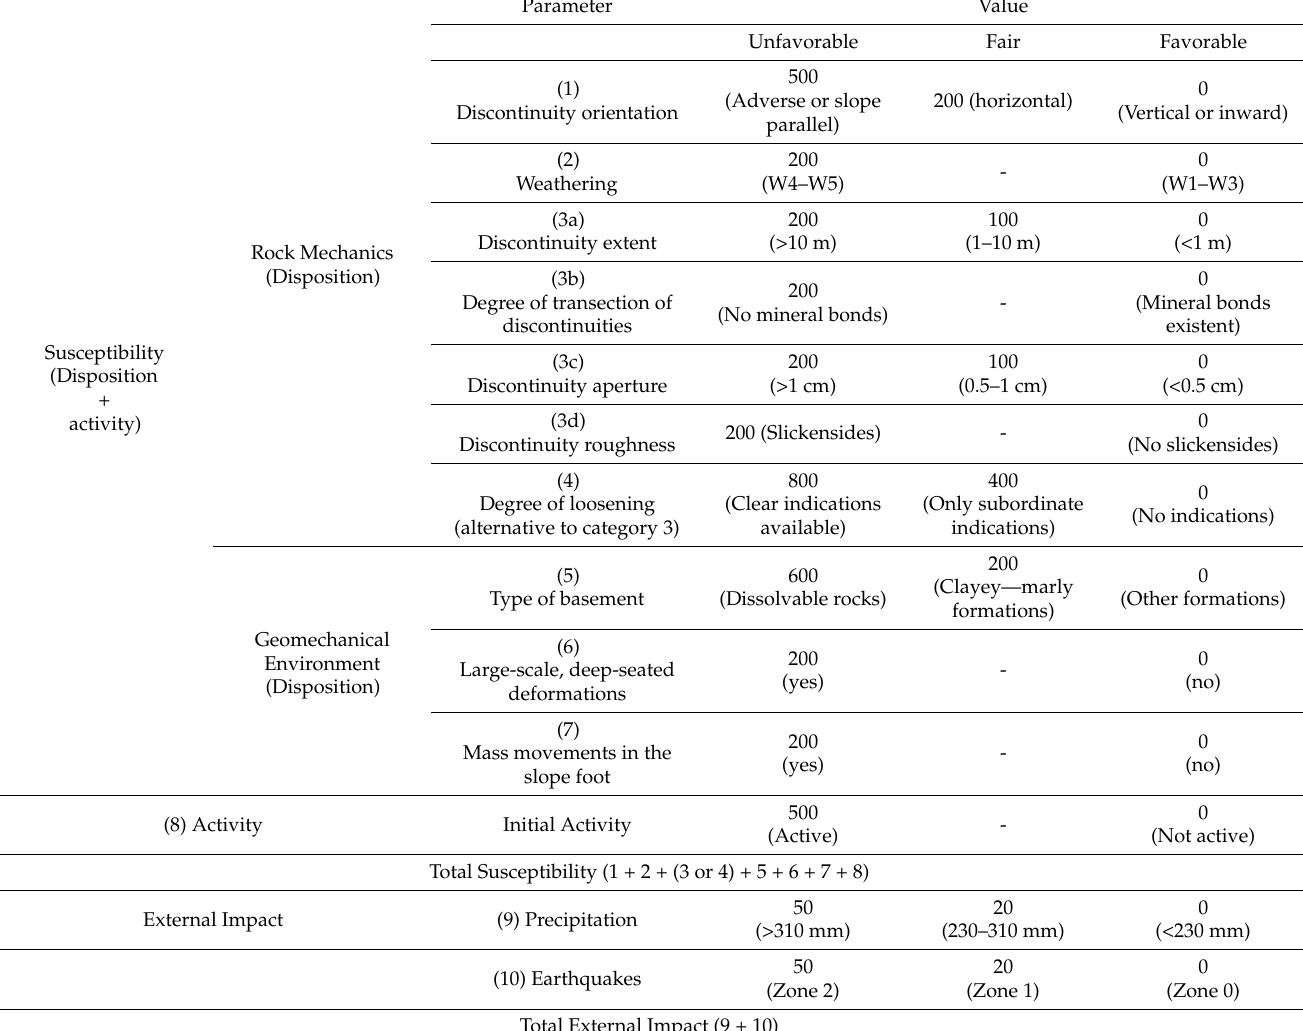
Table 1. Scores of the parameters and rockfall probability values, modified from [8].